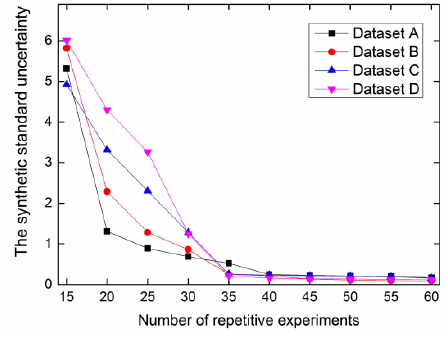
Figure 19. The synthetic standard uncertainty, u C.